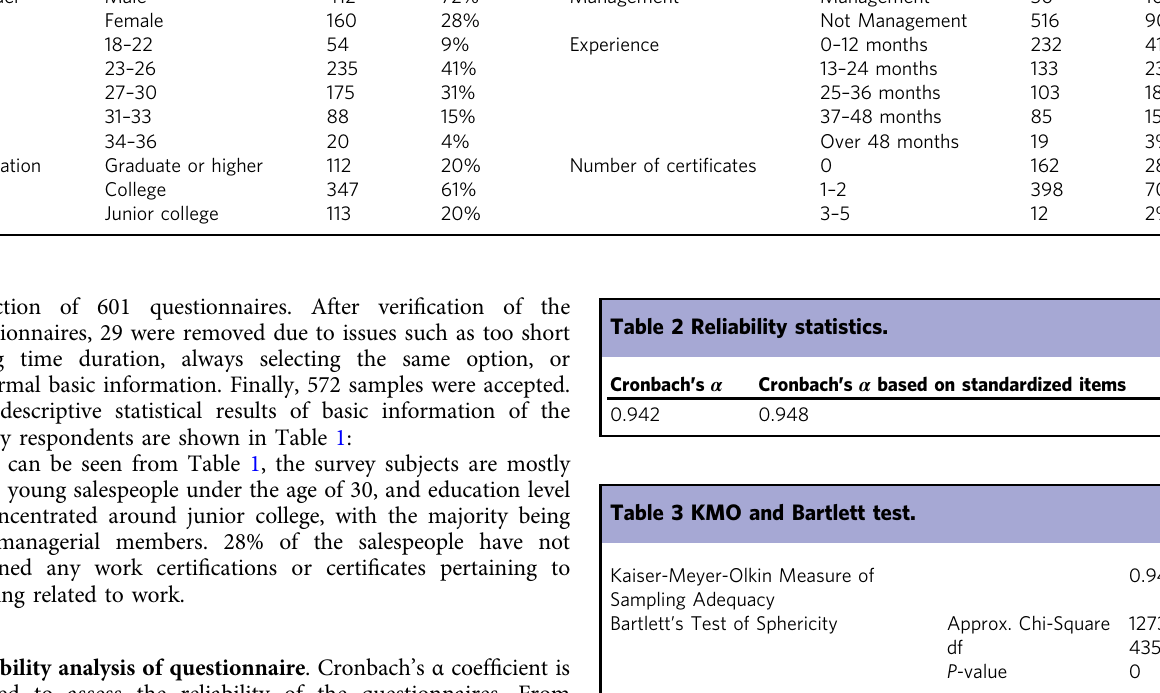
Table 3 KMO and Bartlett